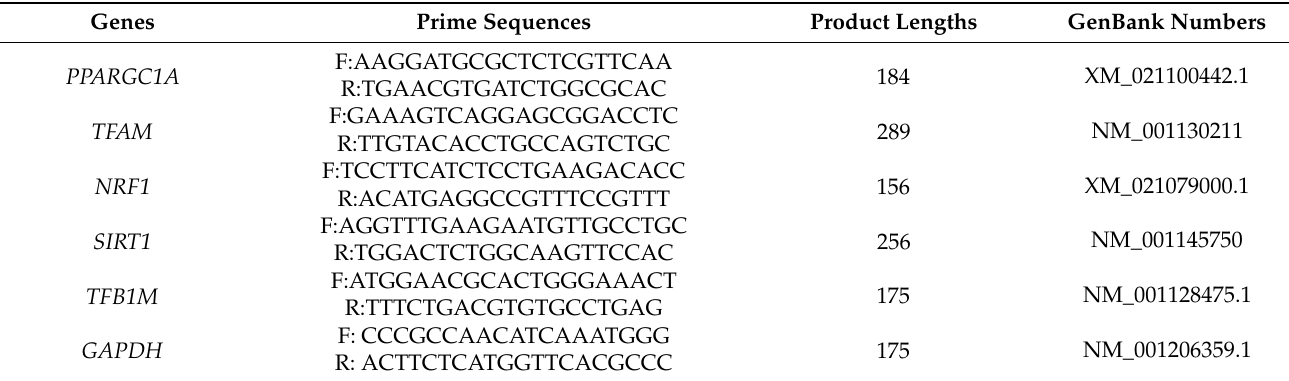
Table 2. Primer sequence of target genes and housekeeping